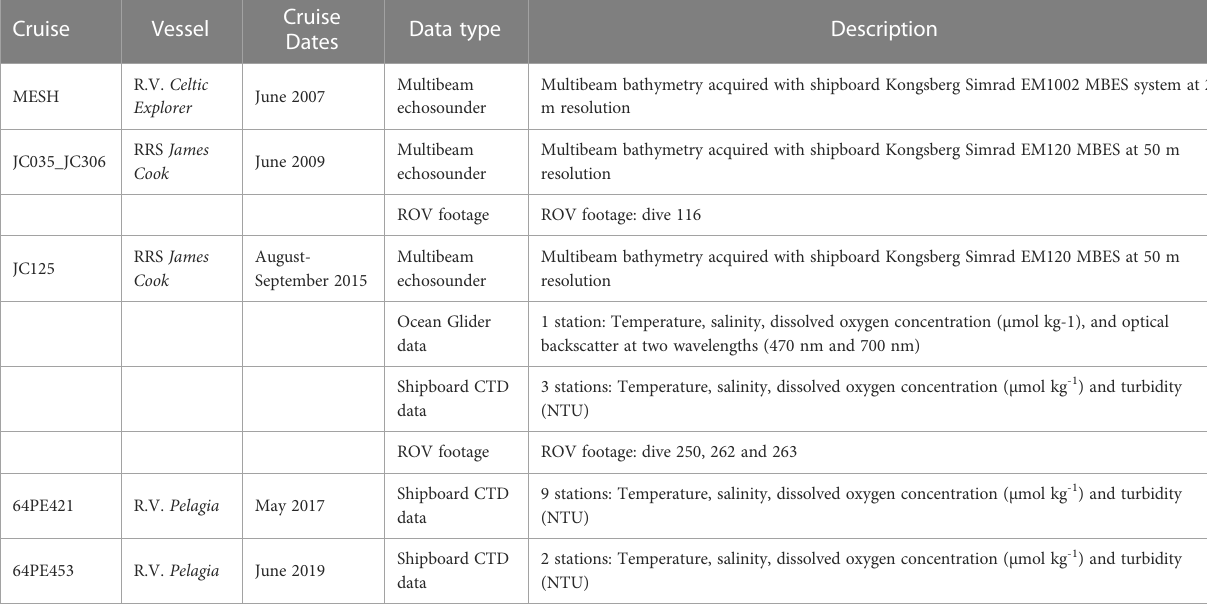
TABLE 1 Details of data used in this study, acquired from different cruises within Whittard